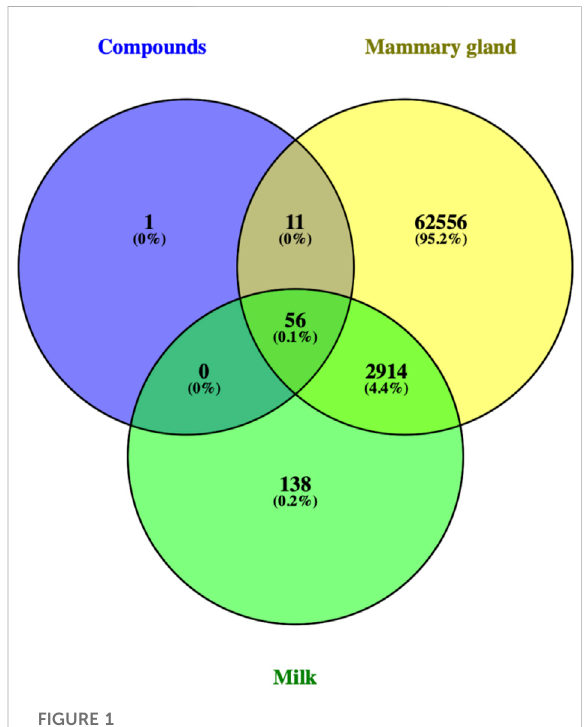
FIGURE 1 Venn diagram showing intersection of 56 ART-related milk biosynthesis